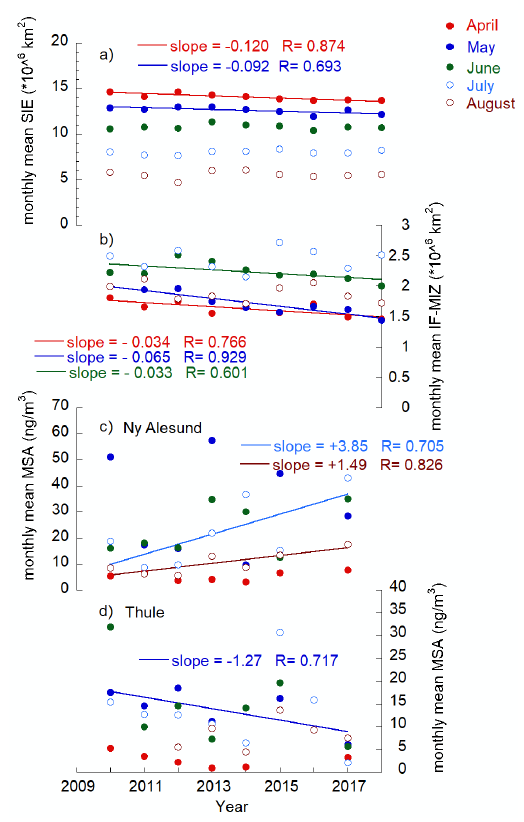
Figure 4. Monthly mean SIE ( a ), IF-MIZ ( b ), and MSA at Ny Ålesund ( c ) and MSA at Thule ( d ) as function on year. Only significant correlation ( p < 0.05) are reported in each plot.